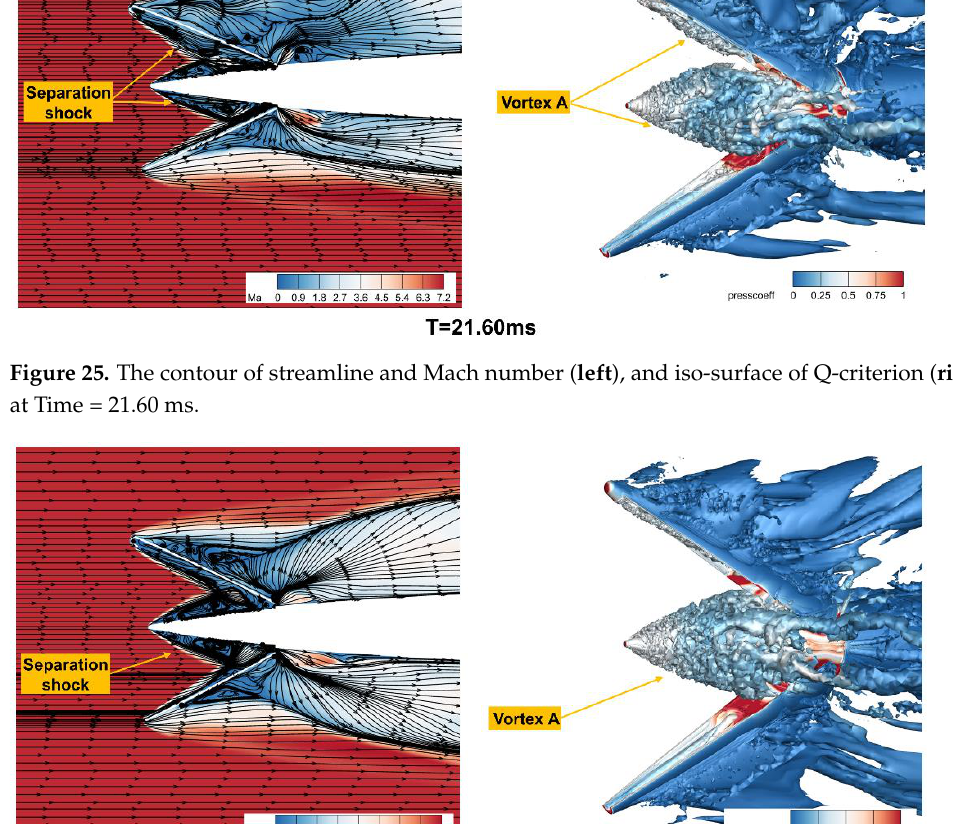
Figure 26. The contour of streamline and Mach number ( left ), and iso-surface of Q-criterion ( right )